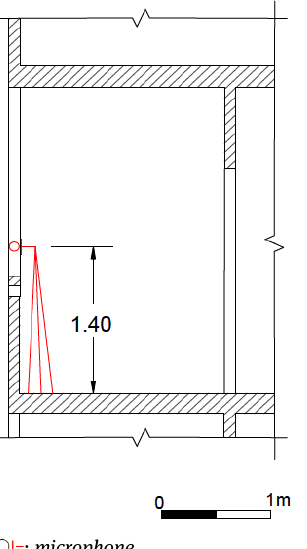
Figure 10: Typical balcony of test building façade, with microphone layout.